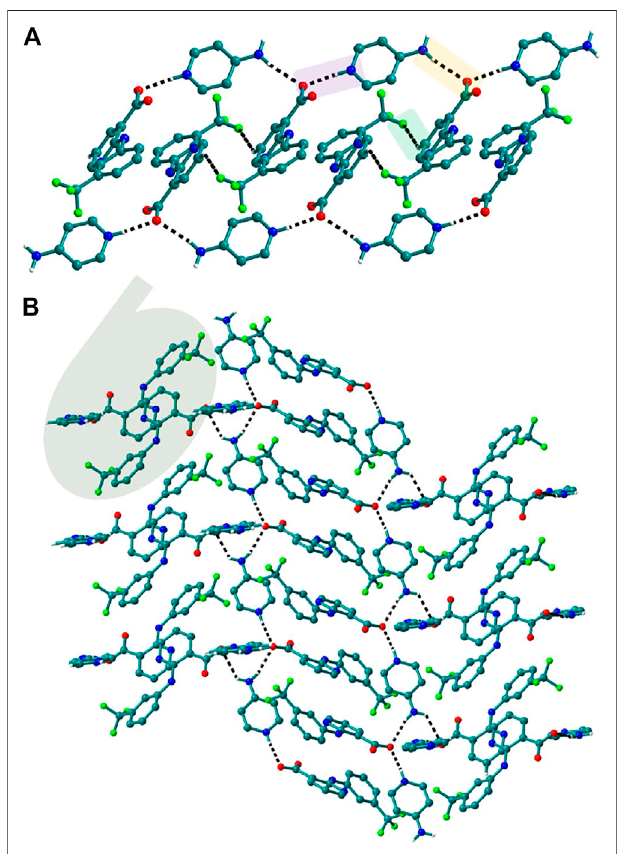
FIGURE 8 | (A) In 6 , Nif ─ 4ap dimers interacted with other dimers via N ─ H ··· O, forming a 1D Chain. (B) The chains are interconnected via C ─ H ··· F and C ─ H ··· O interaction in a perpendicular fashion.